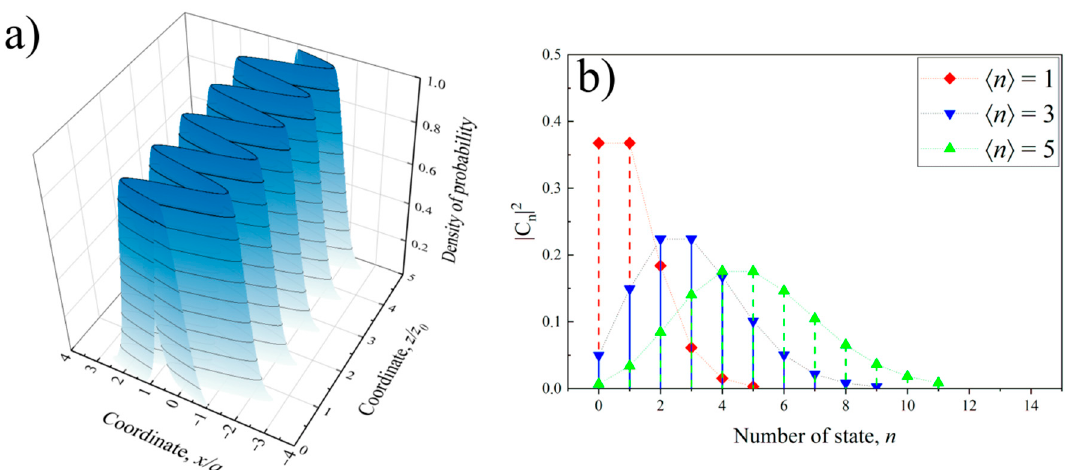
Figure 2. Coherent state of the spatial transverse modes of the beam propagating in the waveguide with the parabolic profile of the susceptibility. ( a ) Squared amplitude of the electric field strength for ⟨𝑛⟩ = 3 . ( b ) Distribution over stationary states for different average numbers of quanta ⟨𝑛⟩ = 1, 3, 5 .